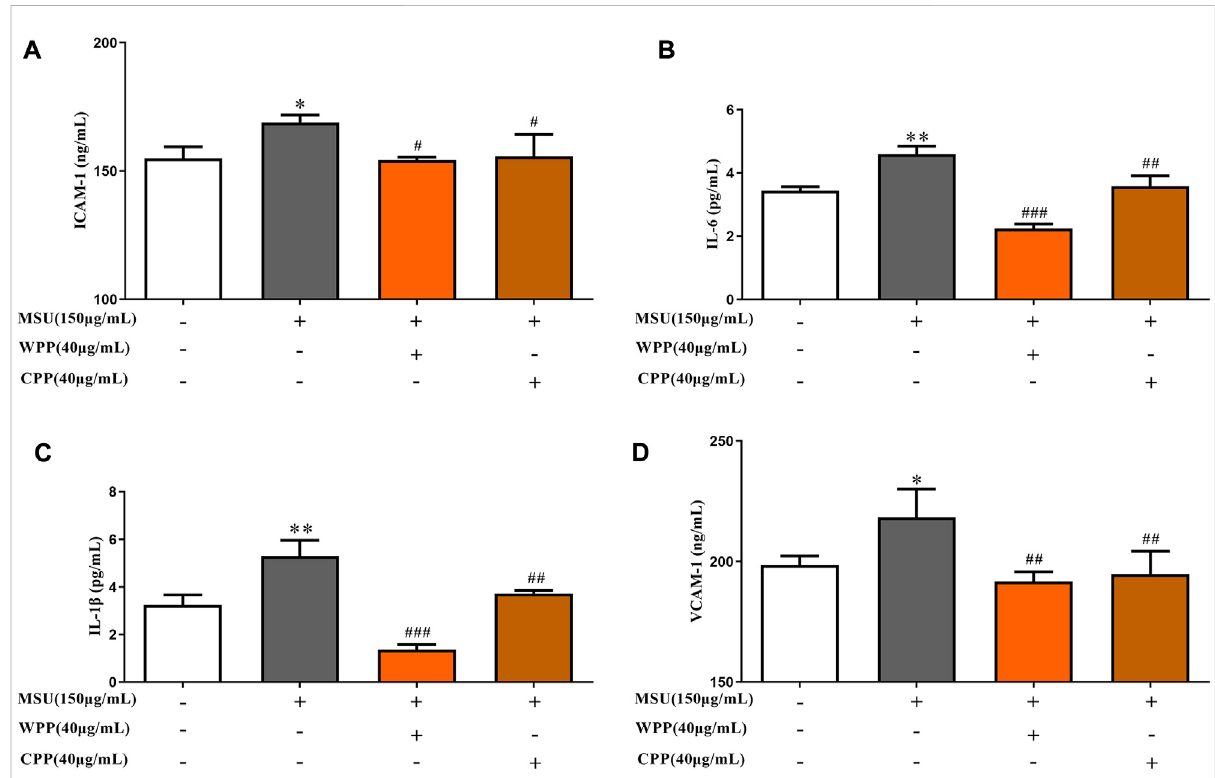
FIGURE 3 Effects ofWPPand CPP onICAM-1 (A) , IL-6 (B) , IL-1 β (C) and VCAM-1 (D) in the in vitro goutmodel, * p < 0.05, ** p < 0.01 vs.control group; # p < 0.05, ## p < 0.01, ### p < 0.001 vs. model group; n =